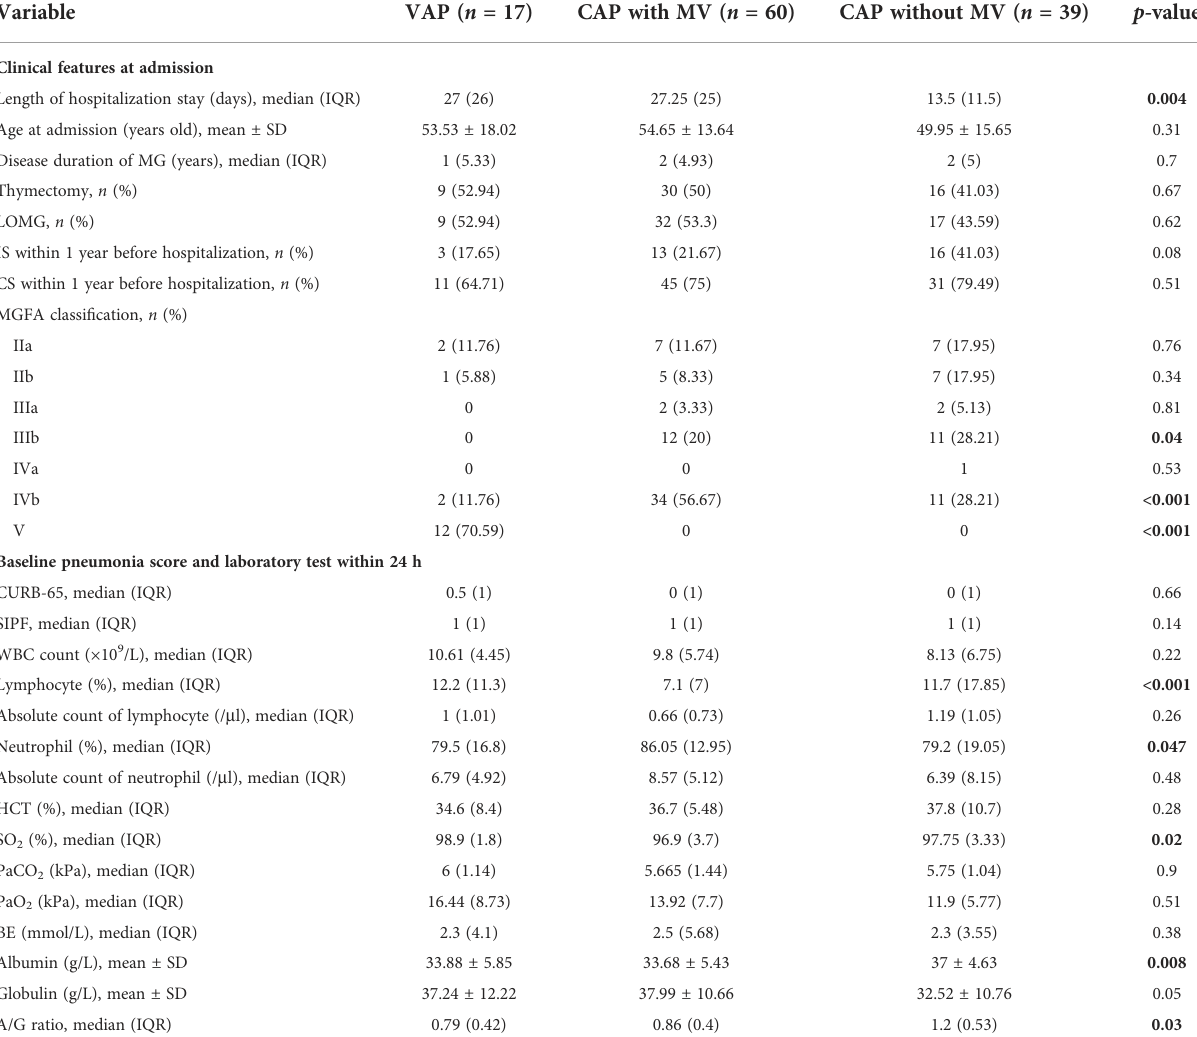
TABLE 1 Comparisons of clinical and laboratory characteristics in three subgroups.